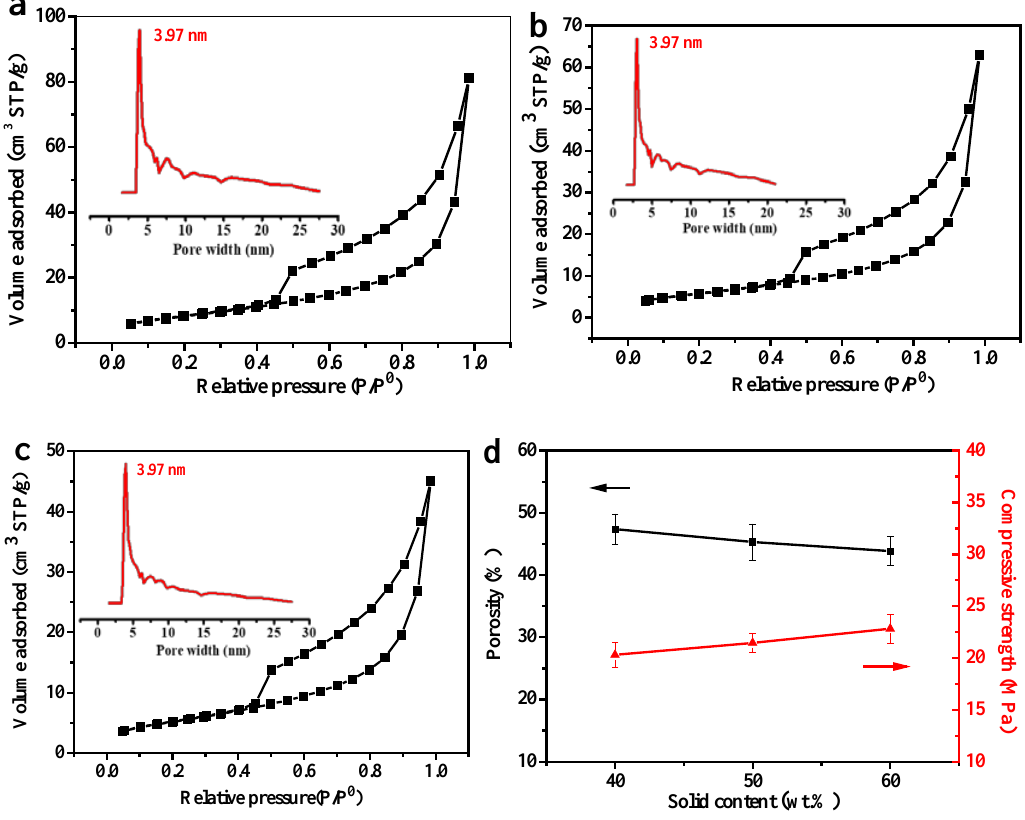
Figure 6. Nitrogen adsorption–desorption curve (in black) and mesoporous pore size distribution (in red) of the PSCM based on the hot–dry casting process with solid contents of ( a ) 40 wt. %, ( b ) 50 wt. %, and ( c ) 60 wt. %. ( d ) Porosity and compressive strength at different solid contents.